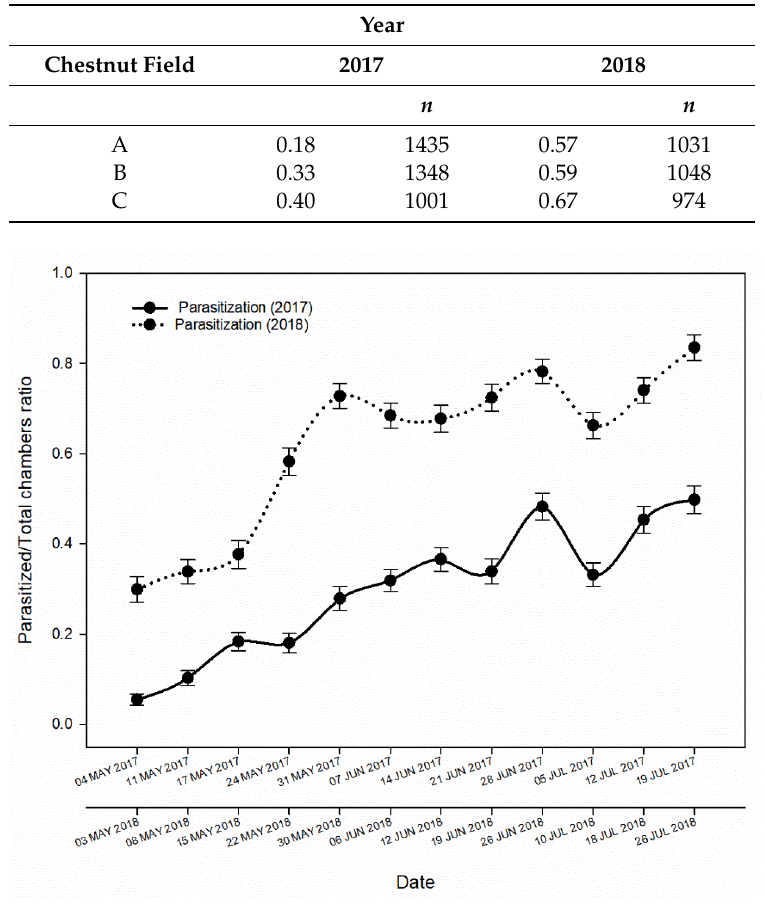
Table 3. Parasitism rate (the number of chambers with living parasitoids (larvae, pupae, adults, emerged insects) divided by the total number of chambers, excluding chambers damaged by rot and without an identifiable host) in the chestnut fields during the monitoring period. n = total number of chambers.